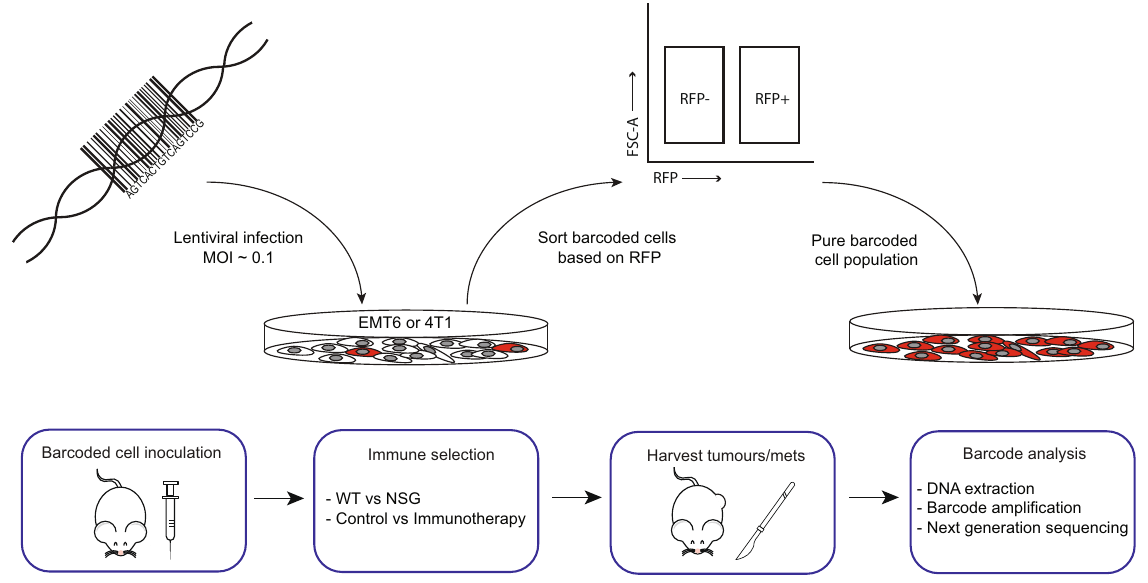
Fig. 1 | Experimental work fl ow schematic. Barcode library is introduced into mammary carcinoma cell lines (EMT6 or 4T1) in vitro at a low multiplicity of infection(MOI).Cellsaresortedbasedonred fl uorescentprotein(RFP)expression toselectthosehavingincorporatedabarcode.Barcodedcellsarethentransplanted into the mammary fat pad of immunocompromised (NSG) or immunocompetent